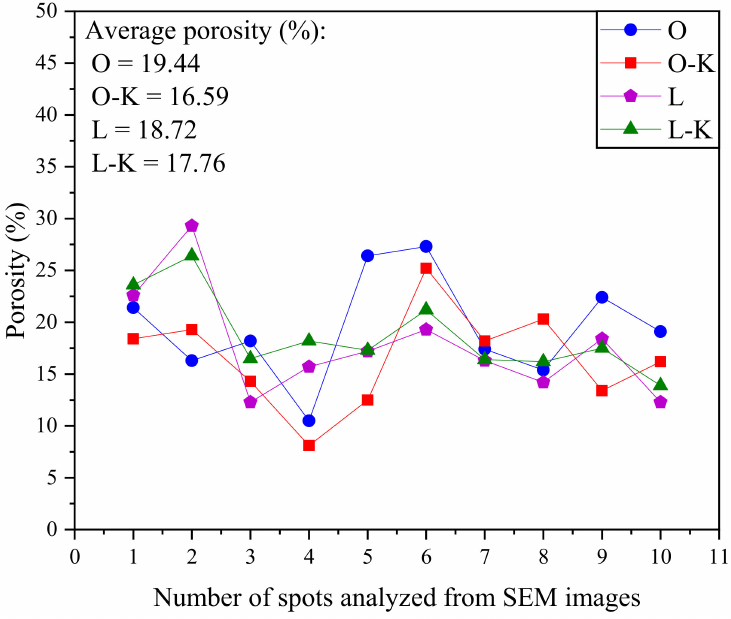
Figure 3. Variation of average cementitious composite porosity with the number of images analyzed with and without